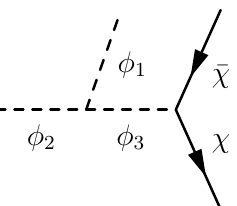
Figure 3. Real φ 1 emission diagram cancelling the IR divergence in the virtual correction to the φ 3 → ¯ χχ